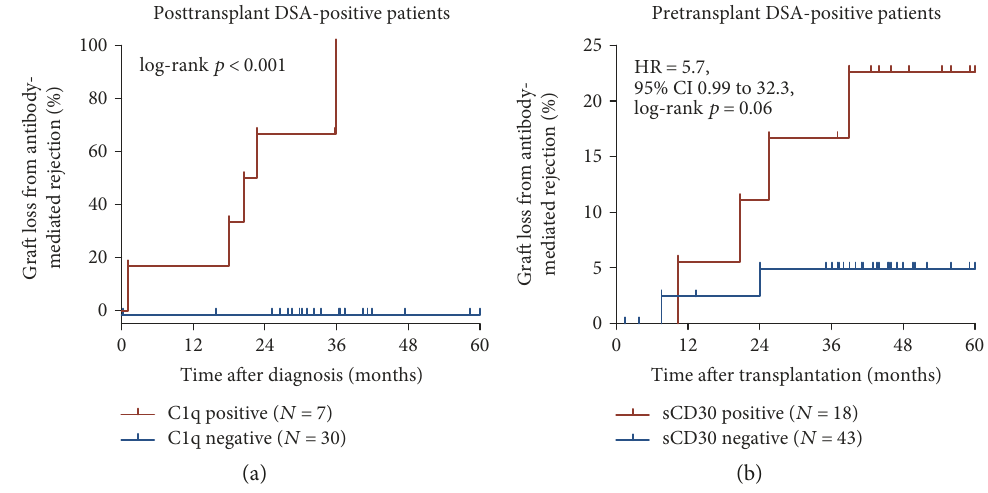
Figure 3: Graft loss from antibody-mediated rejection in high-risk sensitized patients with and without C1q-binding posttransplant donor- speci fi c HLA antibodies (DSA) (a) and in patients who in addition to pretransplant DSA positivity had also increased levels of the immune activation marker sCD30 before transplantation